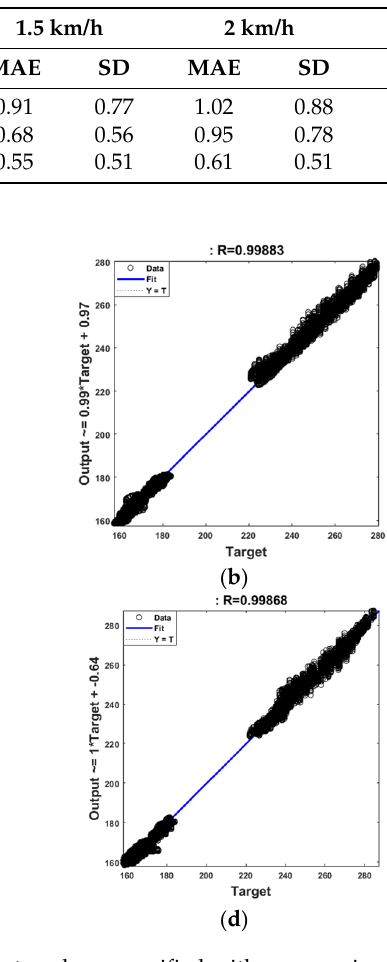
Figure 5. The performance of the neural network was verified with a regression plot: ( a ) walking speed at 1 km/h; ( b ) 1.5 km/h; ( c ) 2 km/h; and ( d ) 2.5